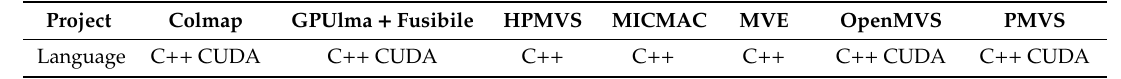
Table 2. Open source software for multi-view stereo technology (MVS).